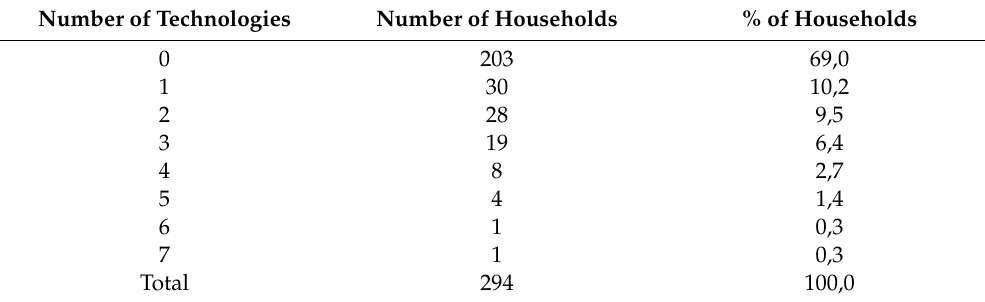
Table 5. Number of technologies matched to a